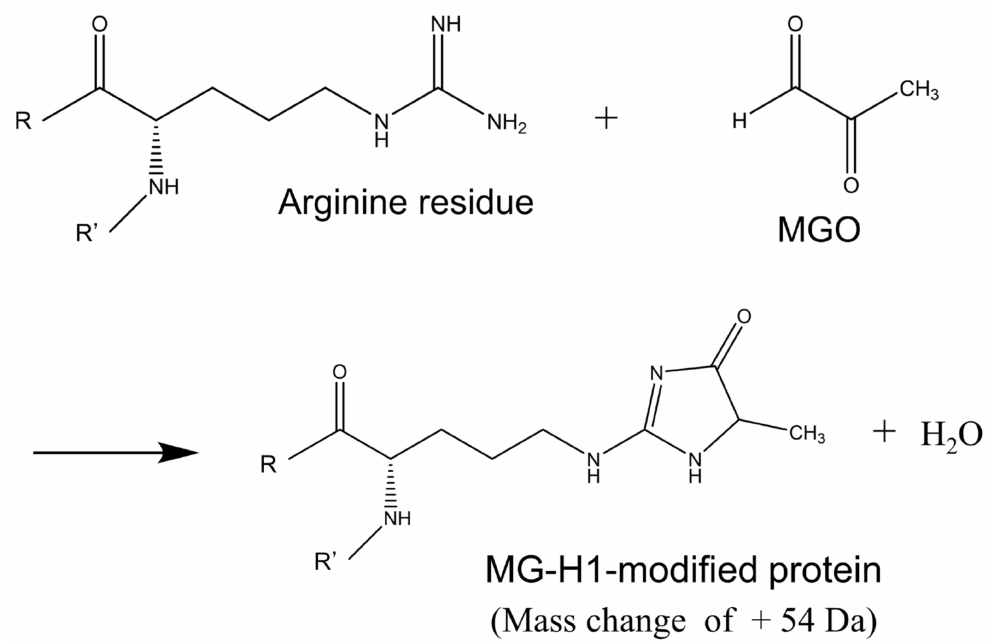
Figure 3. Formation of MG-H1 moiety with the reaction between MGO and arginine residue in the